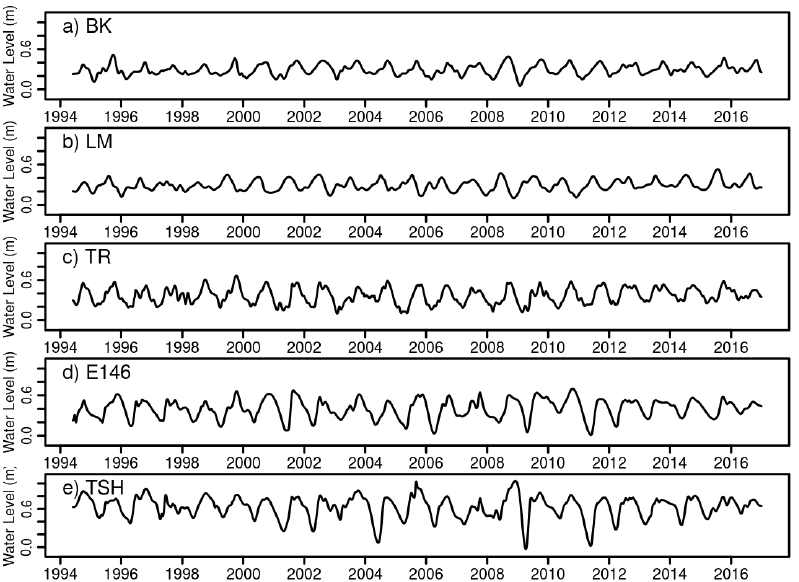
Figure 5. Low frequency cumulative IMFs of water level data in Florida Bay and Taylor Slough shown in Figure 3. ( a ) BK; ( b ) LM; ( c ) TR; ( d ) E146; ( e )